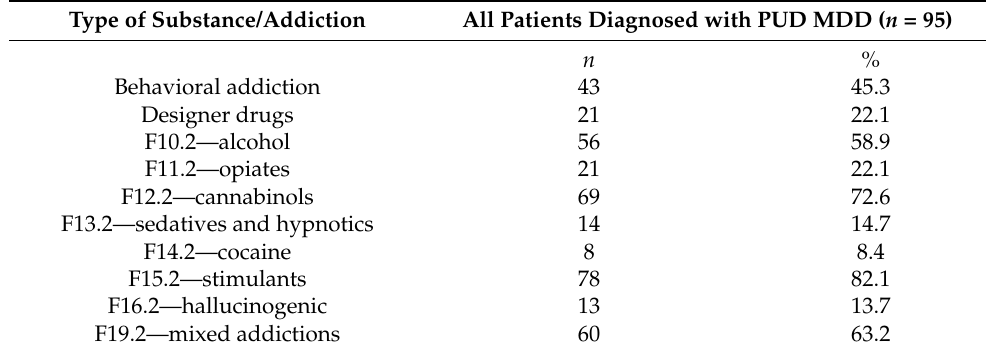
Table 1. Type of psychoactive substance use in addicts. Type of Substance/Addiction All Patients Diagnosed with PUD MDD ( n =